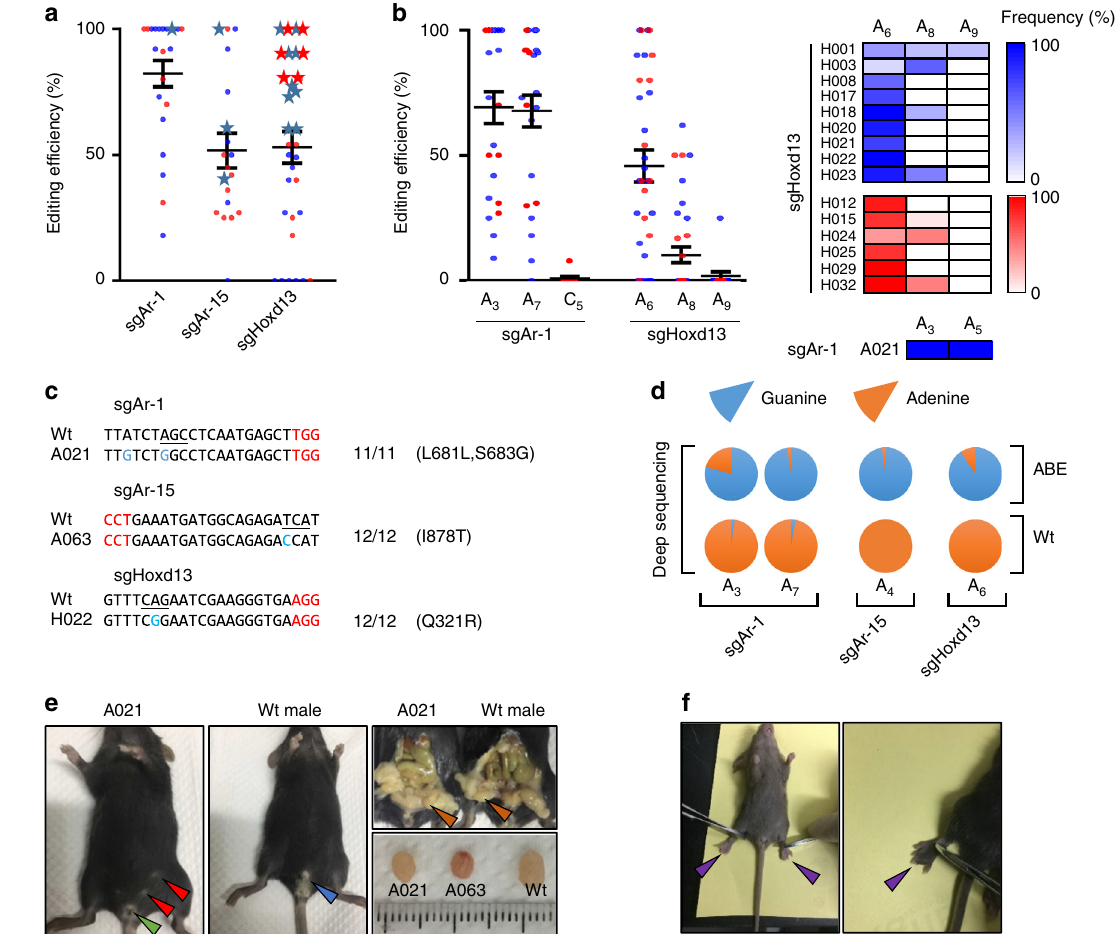
Fig. 2 The generation of Ar and Hoxd13 mutant mouse models by ABE. a The editing ef fi ciencies were detected by Sanger sequencing of TA clones of mouse pups for sgAr-1, sgAr-15, and Hoxd13, respectively. Each dot indicates one individual mouse. At least ten TA clones were analyzed for each sample. Blue dots represent male mice and red dots represent female mice. Asterisks represent the mice with defects. b The editing ef fi ciencies of different positions from individual samples described in a were analyzed. Left: A 3 , A 7 , and C 5 indicate the edited positions of the protospacer for sgAr-1; A 6 , A 8 , and A 9 indicate edited positions of the protospacer for sgHoxd13. Blue dots represent male mice and red dots represent female mice. Right: Editing frequencies in As of each mice with defects for sgHoxd13 and sgAr-1 are displayed in heatmap. Blue rectangles represent male mice and red rectangles represent female. Editing frequencies increase with the increase of color shades. c Representative alignments of modi fi ed sequences from pups after microinjection of ABE mRNA and sgRNAs into one-cell embryos. The PAM sequences and substitutions are highlighted in red and blue, respectively; the target codons are underlined; N/N represents positive colonies out of the total sequenced. d Characterization of the targeted modi fi cations by deep sequencing. The frequencies were calculated from three ( n = 3) replicates. e Sex reversal in founder mouse. Left: a 5-week-old mouse with female genitalia (green arrowhead) and nipples (red arrowheads); middle: Wt male with normal male genital (blue arrowhead); right: founder A021 with internal genitalia of male (orange arrowhead) and smaller testes and founder A063 with smaller testes. f Syndactyly phenotypes of founder mouse. Digits of mutant mouse